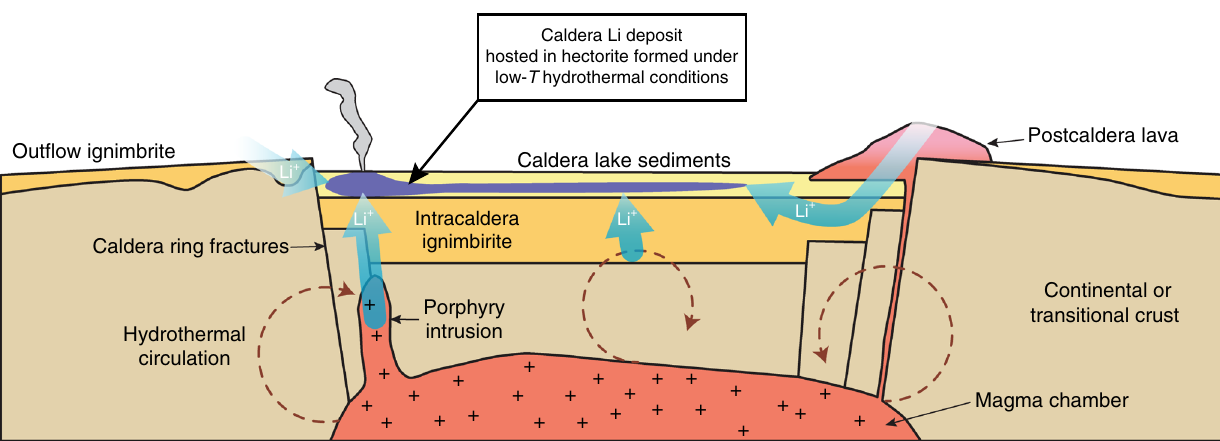
Fig. 5 Schematic model for the formation of caldera-hosted Li clay deposits. Rhyolitic magmas in continental settings have elevated Li concentrations such that eruptions voluminous enough to result in caldera collapse produce volcanic products with suf fi cient total Li to form economic deposits. Post-caldera magmatism contributes additional Li via lavas and outgassing of intrusions; it also generates hydrothermal systems focused along caldera ring fractures. Li is leached from ignimbrite and caldera-related lavas by meteoric and hydrothermal fl uids and is deposited in hectorite clays formed within